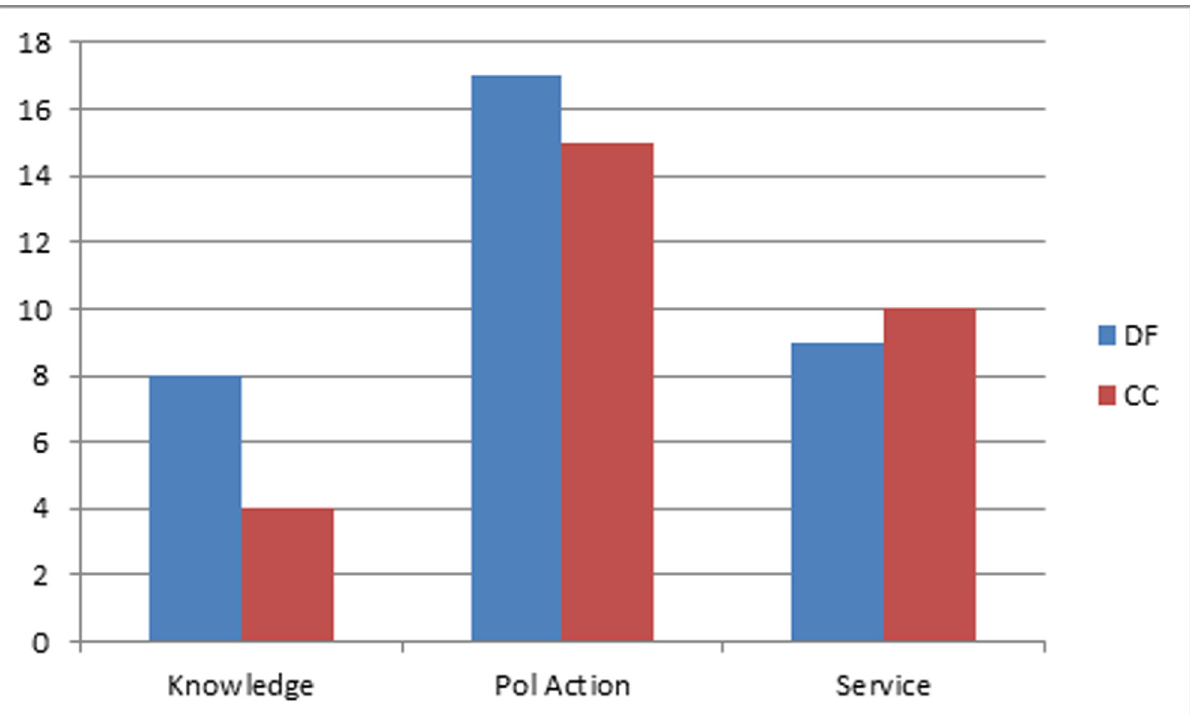
Figure 2: Number of Responses Indicating Different Themes of Civic Responsibilities Among DFs and